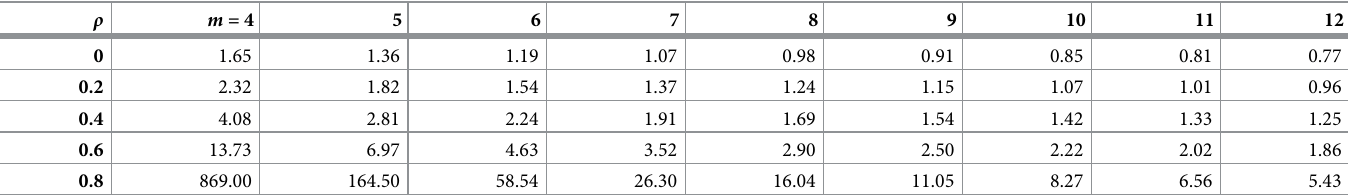
Table 2. Effect sizes of μ (in σ units) detectable with 0.80 power on a 0.10 (one-sided 0.) level test, using the paired serial t -test for level change in Eq 8. A−B ρ m = 4